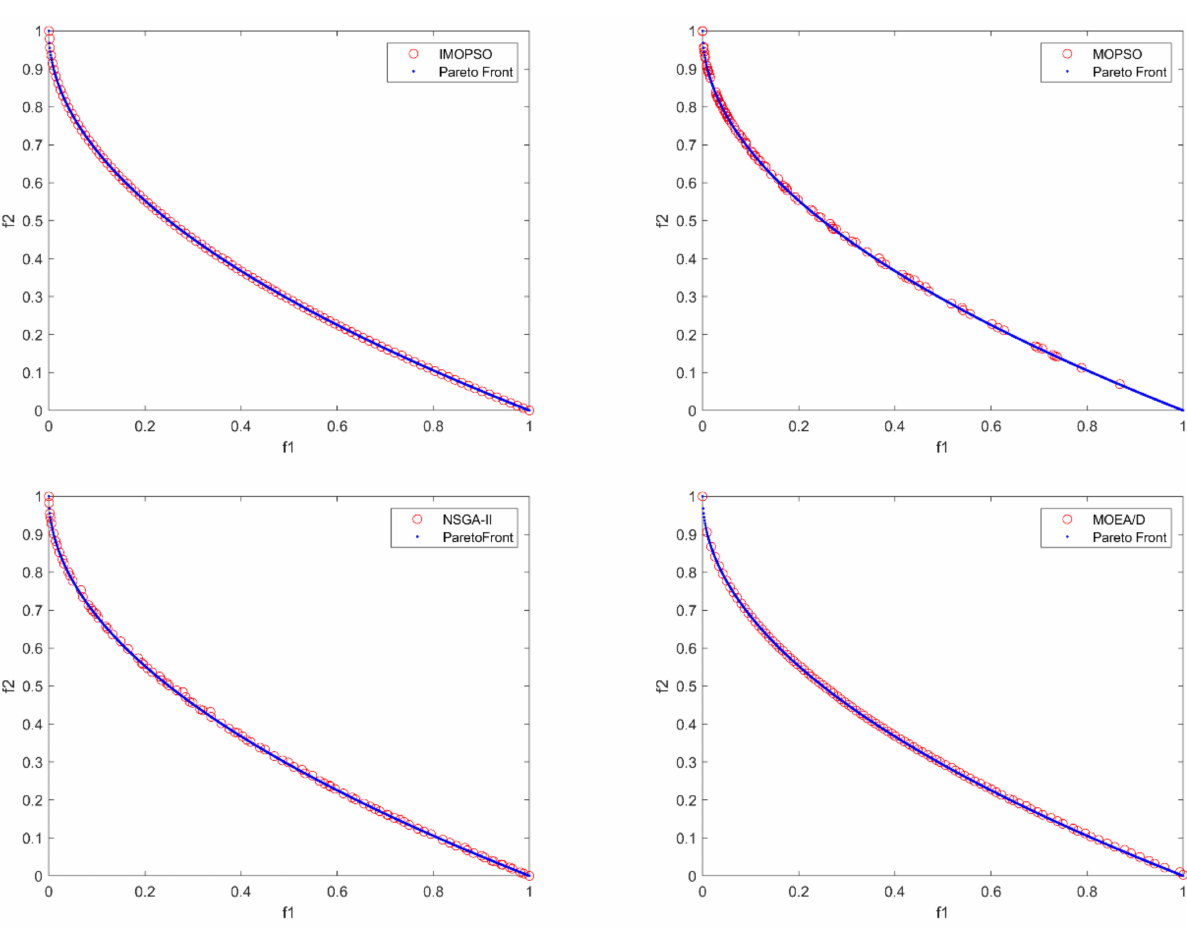
Figure 7. Comparison of the results of four algorithms for solving KUR function.